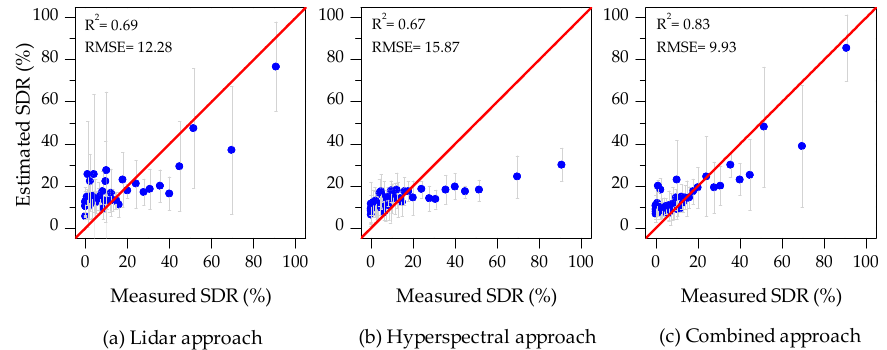
Figure 8. Measured vs. estimated SDR (215 samples) using three different approaches: ( a ) lidar approach, ( b ) hyperspectral approach, and ( c ) combined approach; each point represents the mean (and associated ± 1SD bar) of SDR parameter that yielded the five nearest measured values of the individual tree crown. Table 5. Comparison of the lidar and combined approach on the classification accuracy of different damaged degrees. Healthy Slightly Moderately Severely Dead SDR: 0 – 10%